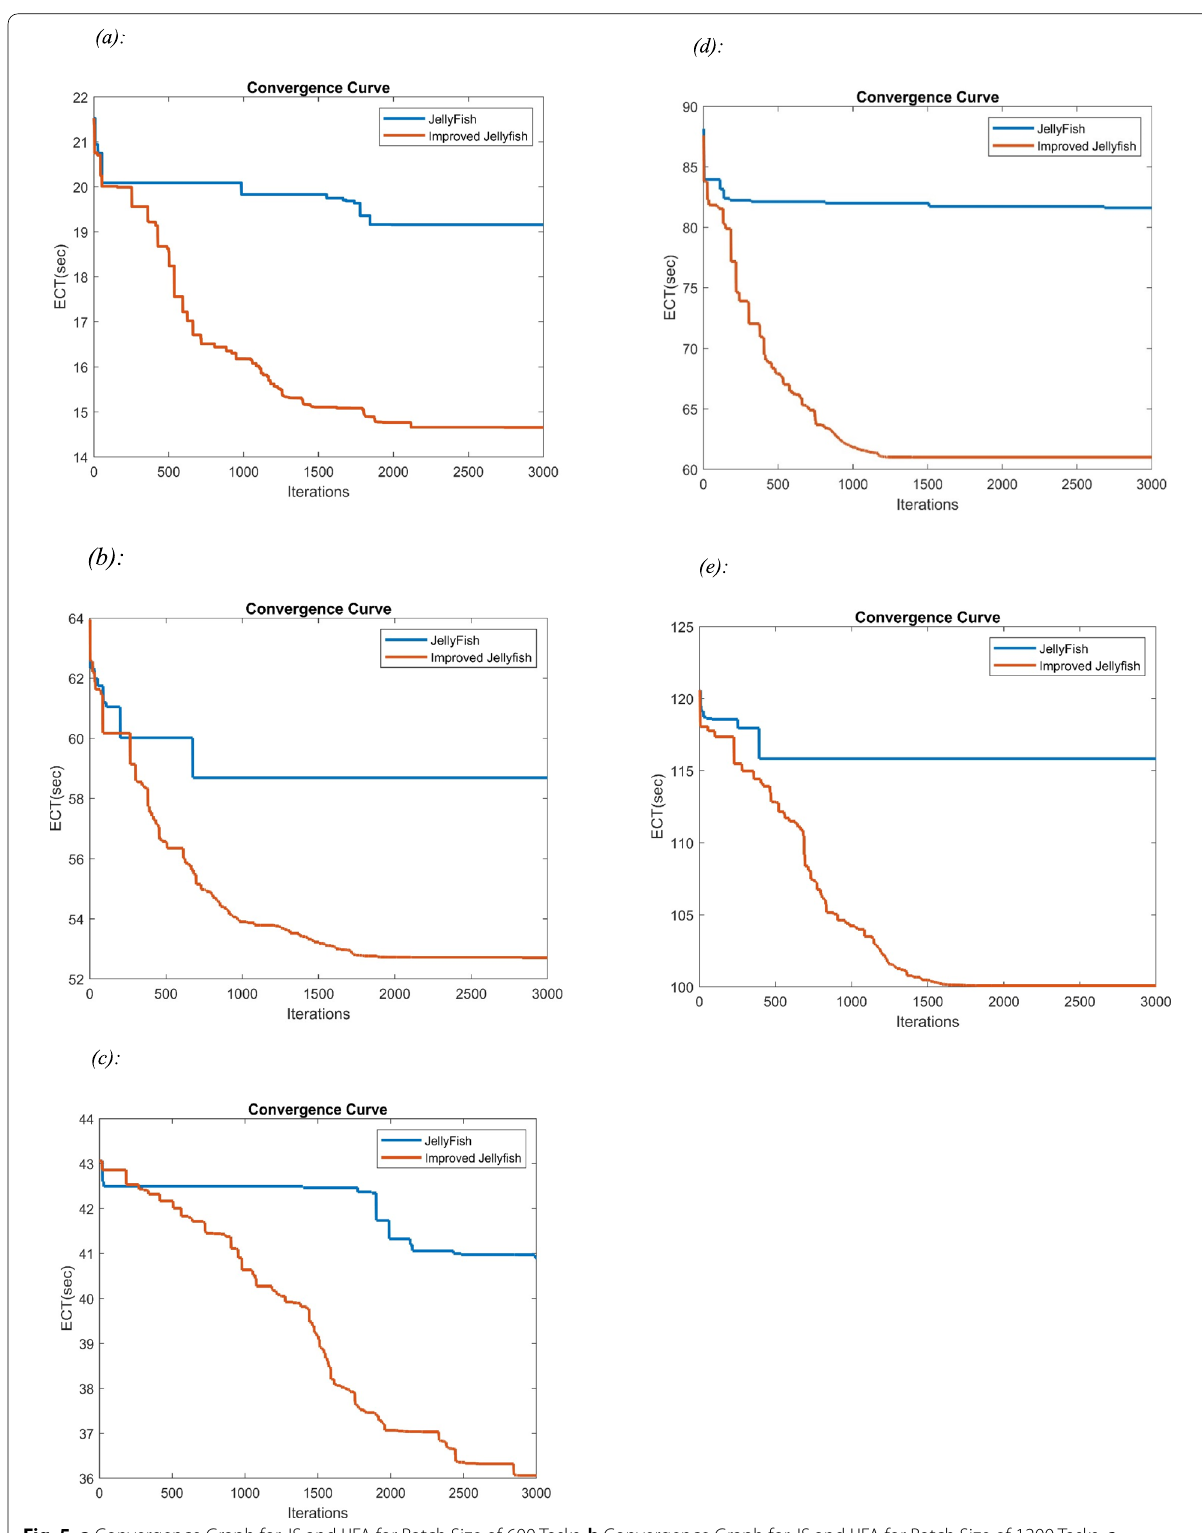
Fig. 5 a Convergence Graph for JS and IJFA for Batch Size of 600 Tasks. b Convergence Graph for JS and IJFA for Batch Size of 1200 Tasks. c Convergence Graph for JS and IJFA for Batch Size of 1800 Tasks. d Convergence Graph for JS and IJFA for Batch Size of 2400 Tasks. e Convergence Graph for JS and IJFA for Batch Size of 3000